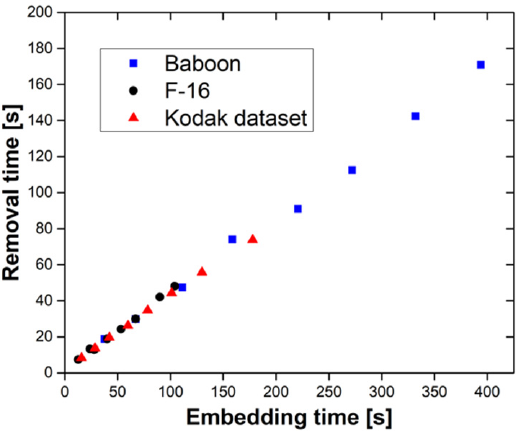
Figure 13. Embedding time according to ( a ) hiding rate with F = C = 8, ( b ) number of blocks ( F × C ) for a hiding rate equal to 0.2 bpp, and ( c ) image size with a hiding rate of 0.5 bpp and F = C = 8.